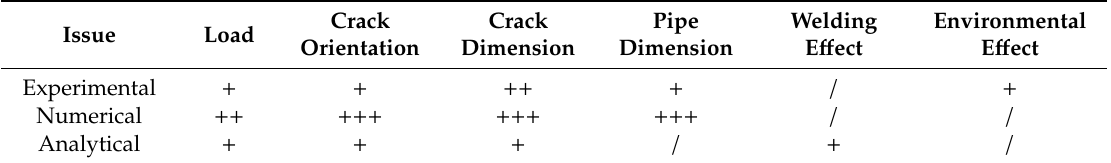
Table 1. A summary of the main research interests on the issue of surface cracked